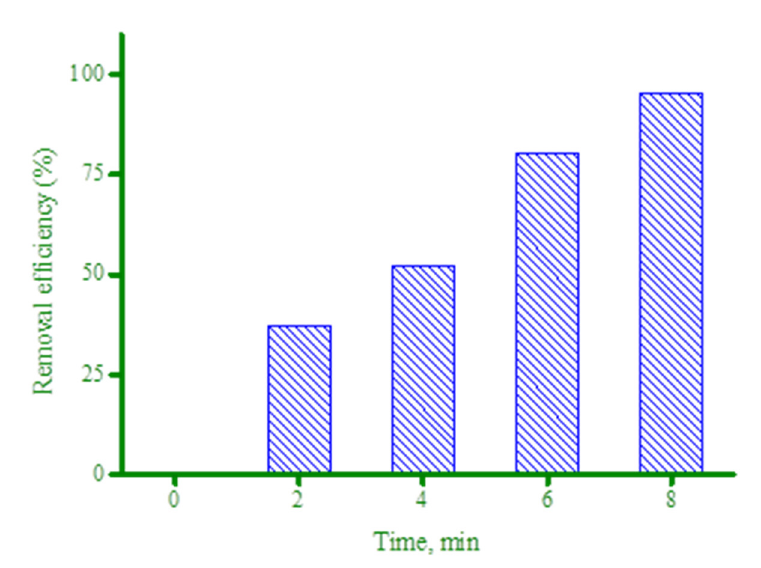
Figure 16. Removal efficiency (%) of AC (10 mg in 100 mL of deionized water) using 40 mg of the synthesized CrFeO3-CNT adsorbent at different contact times.